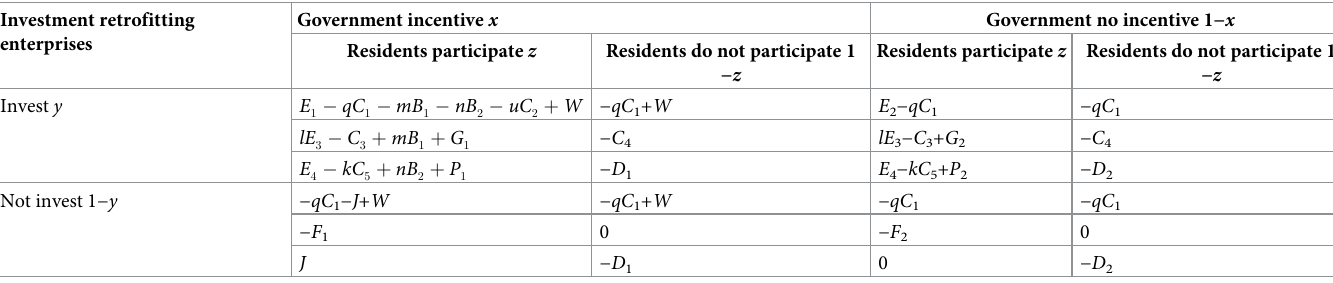
Table 2. Payoffs matrix for green retrofitting of traditional residential buildings. Investment retrofitting